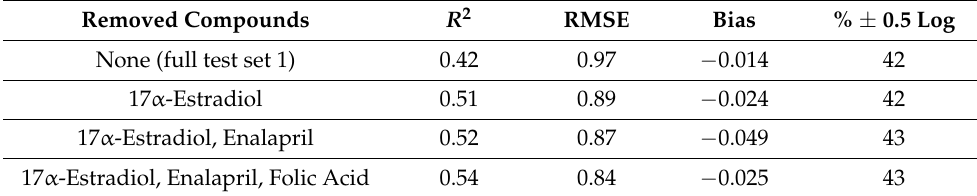
Table 5. Statistical MPPs obtained on test set 1 after removal of outliers. Removed Compounds R 2 RMSE Bias